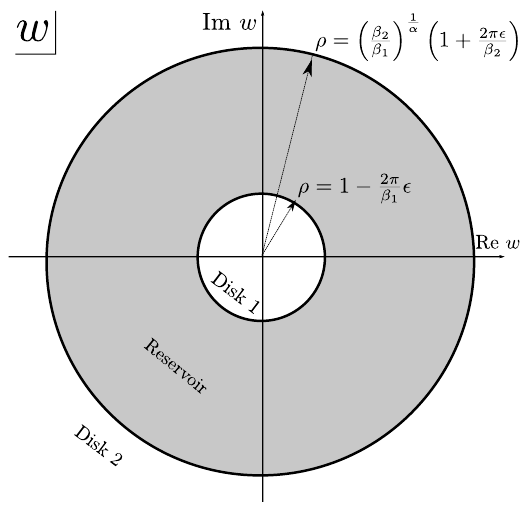
Figure 6. Euclidean geometry of two black holes coupled via a reservoir conformally mapped to a plane. The shaded region is the